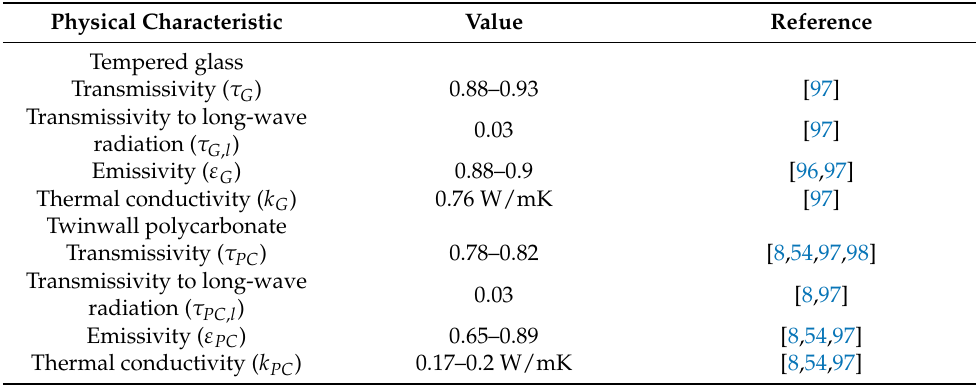
Table A1. Physical characteristics of greenhouse covering